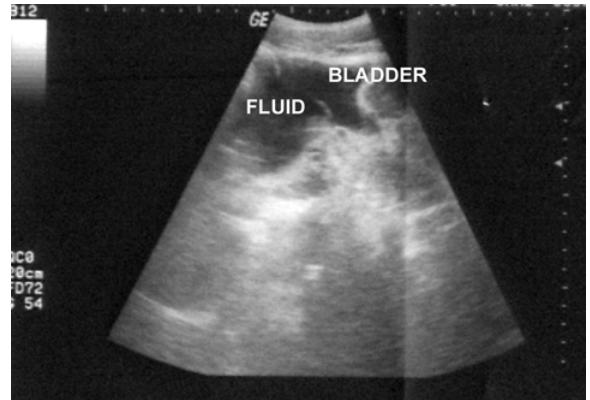
Figure 2 – Sonography showing discontinuity of peritoneal blad- der wall.